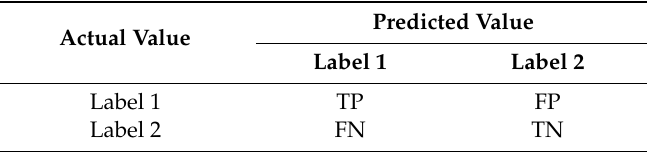
Table 1. The model of the confusion